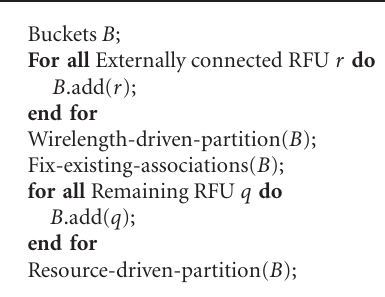
Algorithm 3: Partitioning into